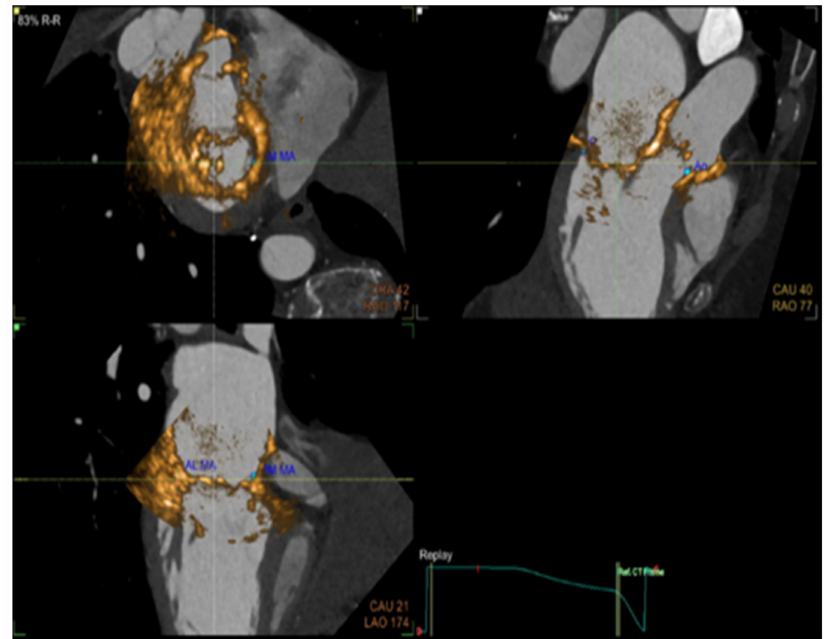
Figure 14. CT Fusion image the display of co-aligned 4D TEE ultrasound and CT